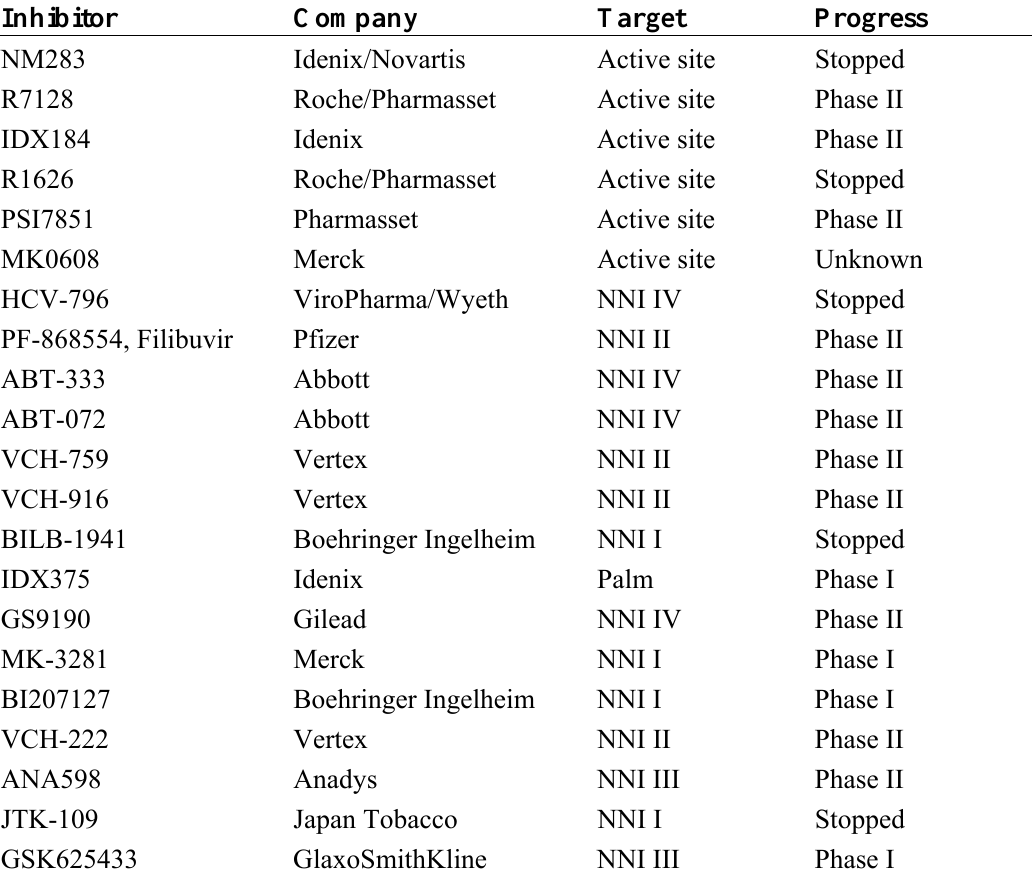
Table 1. Clinical progress of HCV NS5B nucleoside and non-nucleoside